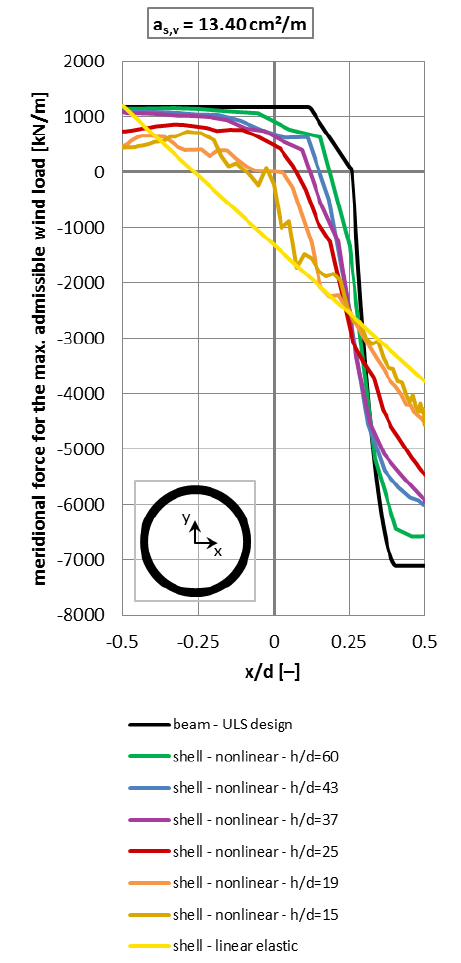
Figure 7. Load bearing capacity for predefined rein- forcement acc. to beam theory, linear and nonlinear shell theory.